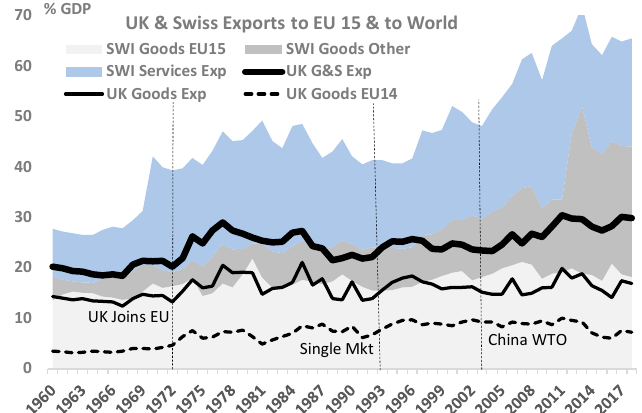
Figure 6. UK and Swiss Exports to the Original EU Countries and to the World (%GDP), Compared. Source: Thomson Reuters.